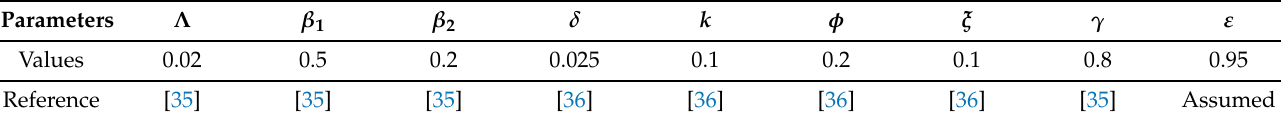
Table 4. Parametric values used in system (3) when β 1 > β 2 , E 1 = ( 0.1254,0.0519,0.5429,0.0783 ) and R 0 = 1.6246. Parameters